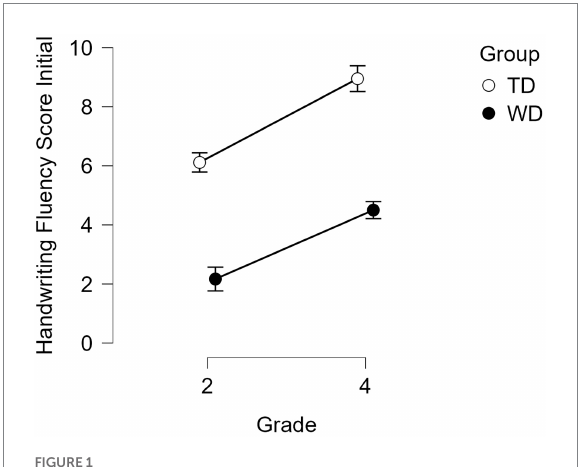
FIGURE 1 Descriptive plots of the initial identification handwriting task, as found in Pascual